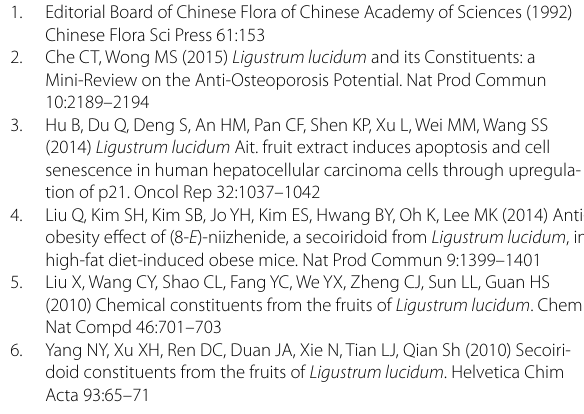
Fig. 7 Effects of polysaccharides on plasma coagulation parameters in vitro ( a APPT; b PT; c TT; d FIB. n .001 < **p < 0.01 < *p < 0.05; Compared with Yunnan Baiyao, # ## p < 0.001 < ## p < 0.01 < # p < 0.05; Compared with breviscapine, △△△ p < 0.001 < △ △ p < 0.01 < △ p <